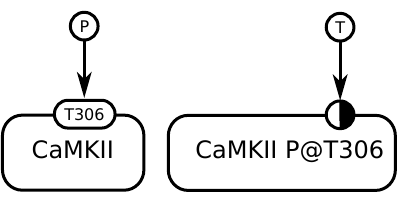
Figure 2.2: The two ways to represent phosphorylation of the protein: by assigning “P” to the state variable (left), and by setting existence to phosphorylated entity